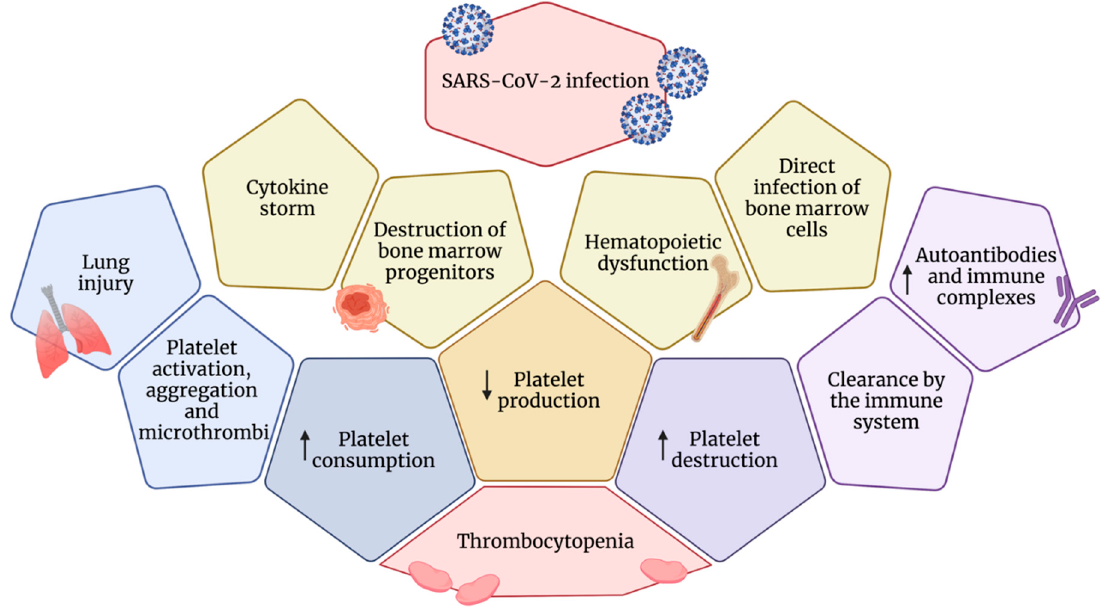
Figure 4. Mechanisms leading to thrombocytopenia in COVID-19 patients. Thrombocytopenia in SARS-CoV-2 is related to decreased platelet production, increased platelet consumption, and destruction.